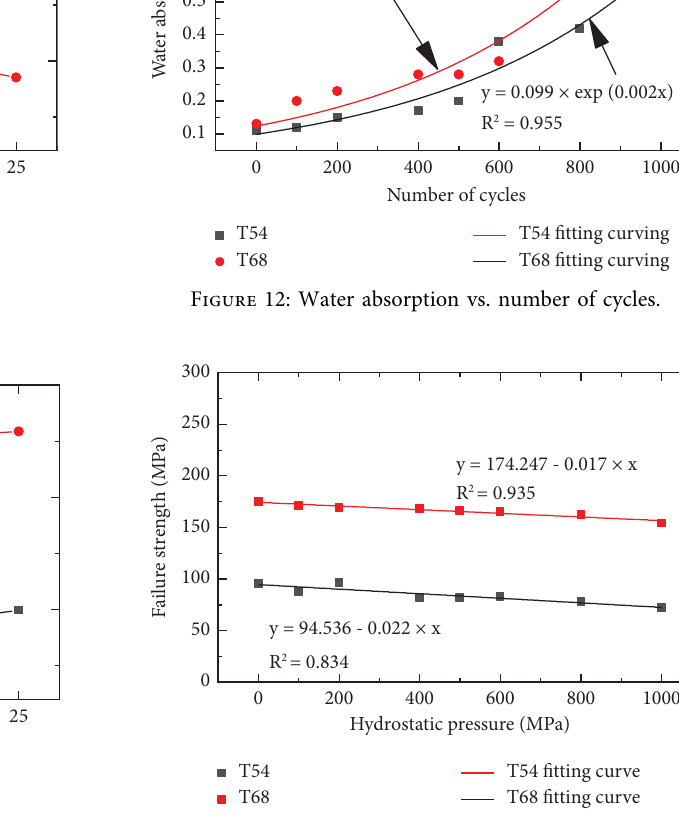
Figure 13: Failure strength vs. hydrostatic